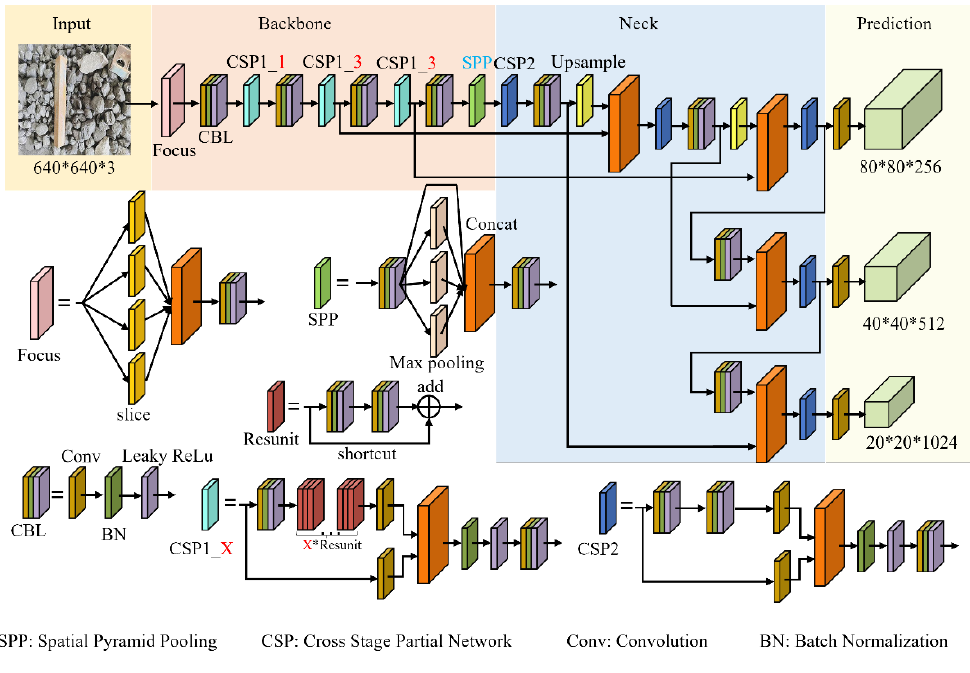
Figure 1. Structure of a Yolov5 network.